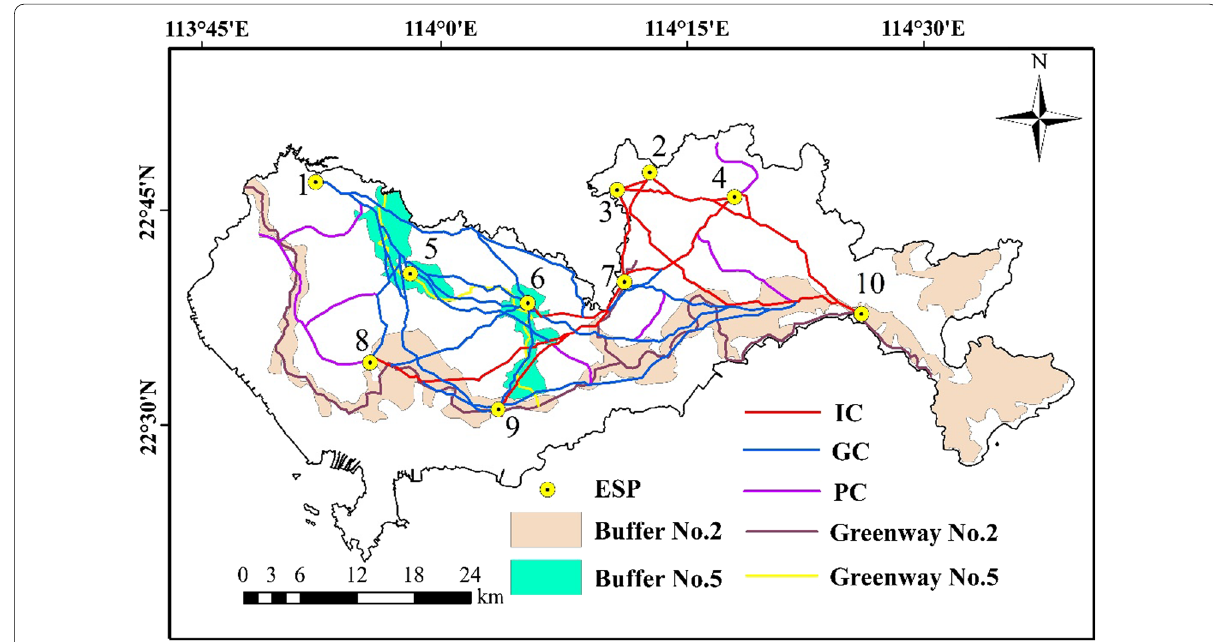
Fig. 8 Optimized ecological networks overlaid on the greenway network of the Pearl River Delta in Shenzhen City (revised from the Housing and Urban–Rural Development Department of Guangdong Province in PRC (2010)). Numbers from one to ten mark the locations of the ten ecological source points. ESP ecological source point; IC, important corridor; GC, general corridor; PC, potential